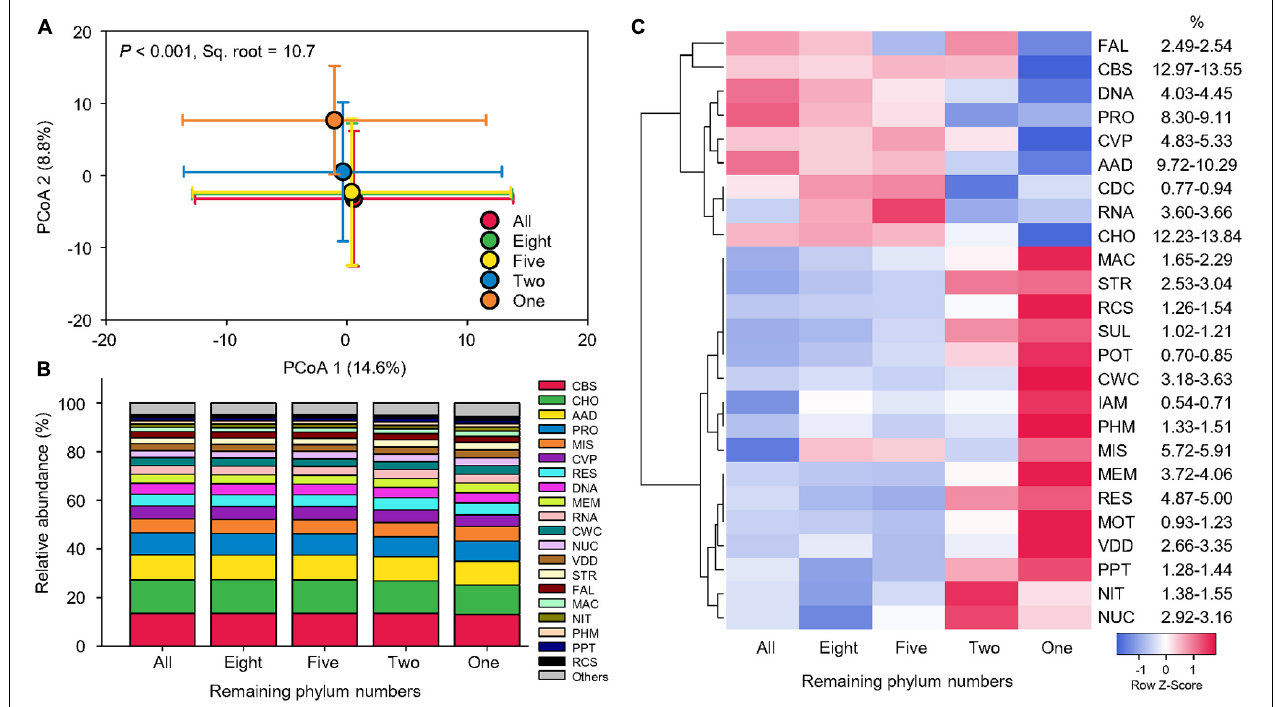
FIGURE 4 | Stable functional structure. (A) Principal coordinate analysis (PCoA) showing the beta-diversity of functional profiles at the genus level affected by sequential species loss. The error bars represent the standard deviation of data ranges. Variation explained by two principal coordinate dimensions is given in parentheses by percentage. p values and Sq. root of PERMANOVA are also given. (B) Relative abundance of dominant functional categories at level 1 (mean > 1%) affected by sequential species loss. (C) Heatmaps showing normalized relative abundance of dominant functional categories at level 1 (mean > 1%) affected by sequential species loss. Dendrograms of hierarchical cluster analysis grouping functions are shown. AAD, amino acids and derivatives; CBS, clustering-based subsystems; CDC, cell division and cell cycle; CHO, carbohydrates; CVP, cofactors, vitamins, prosthetic groups, pigments; CWC, cell wall and capsule; DNA, DNA metabolism; FAL, fatty acids, lipids, and isoprenoids; IAM, iron acquisition and metabolism; MAC, metabolism of aromatic compounds; MEM, membrane transport; MIS, miscellaneous; MOT, motility and chemotaxis; NIT, nitrogen metabolism; NUC, nucleosides and nucleotides; PHM, phosphorus metabolism; POT, potassium metabolism; PPT, phages, prophages, transposable elements, plasmids; PRO, protein metabolism; RCS, regulation and cell signaling; RES, respiration; RNA, RNA metabolism; STR, stress response; SUL, sulfur metabolism; and VDD, virulence, disease, and